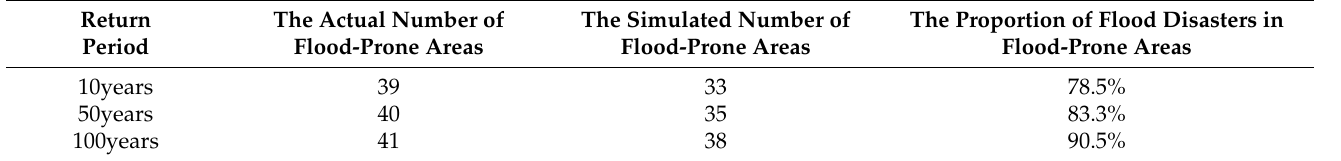
Table 2. Calibration results of flood-prone areas.